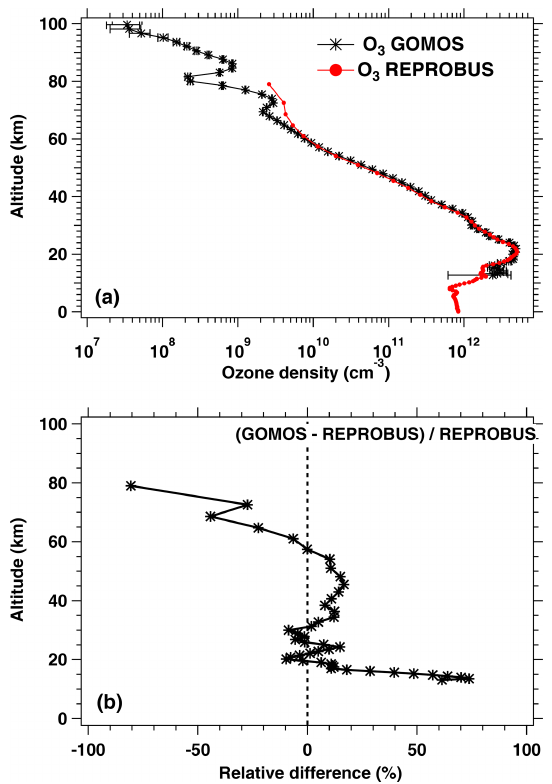
Figure C1. (a) One typical example of comparison of a GO- MOS vertical ozone profile (black curve) versus REPROBUS pre- diction (red curve). The GOMOS profile was observed during the night on 8 January 2007. (b) Relative difference ( GOMOS − REPROBUS )/